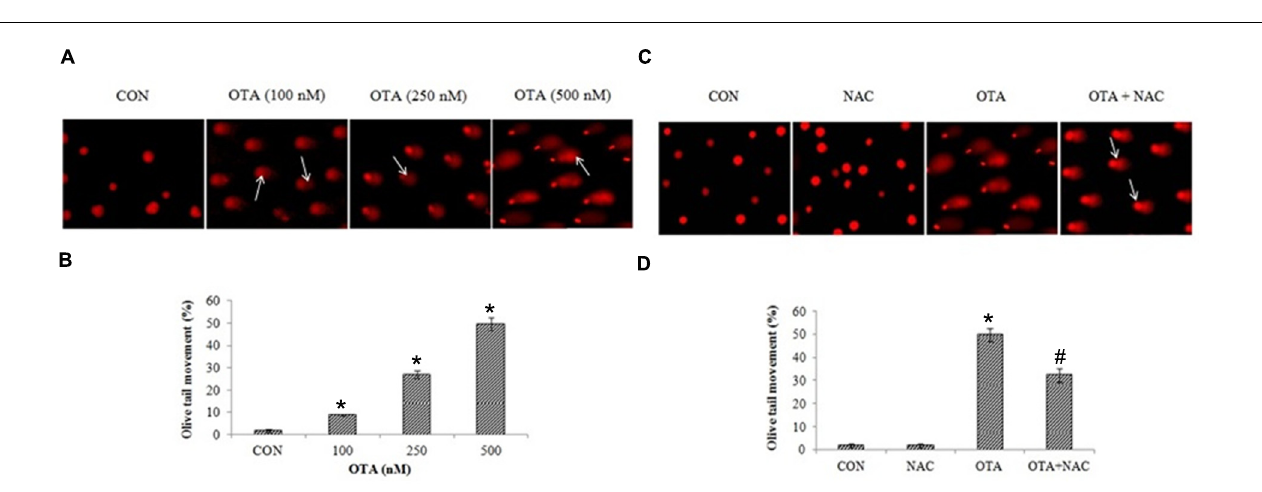
FIGURE 6 | OTA treatment induced DNA double strand breaks in Neuro-2a cells. (A) The photomicrographs represent the levels of DNA damage in Neuro-2a cells followed by without or with different concentrations of OTA treatment. (B) The tail lengths of the comet was measured in each cell using Comet assay IV software and represented as percent olive tail moment. (C) Neuro-2a cells were pretreated with NAC (1 mM) for 24 h followed by OTA (500 nM) treatment for 24 h and DNA damage was monitored and photographed (D) Tail lengths of the comet was measured by using Image pro R (cid:13) plus